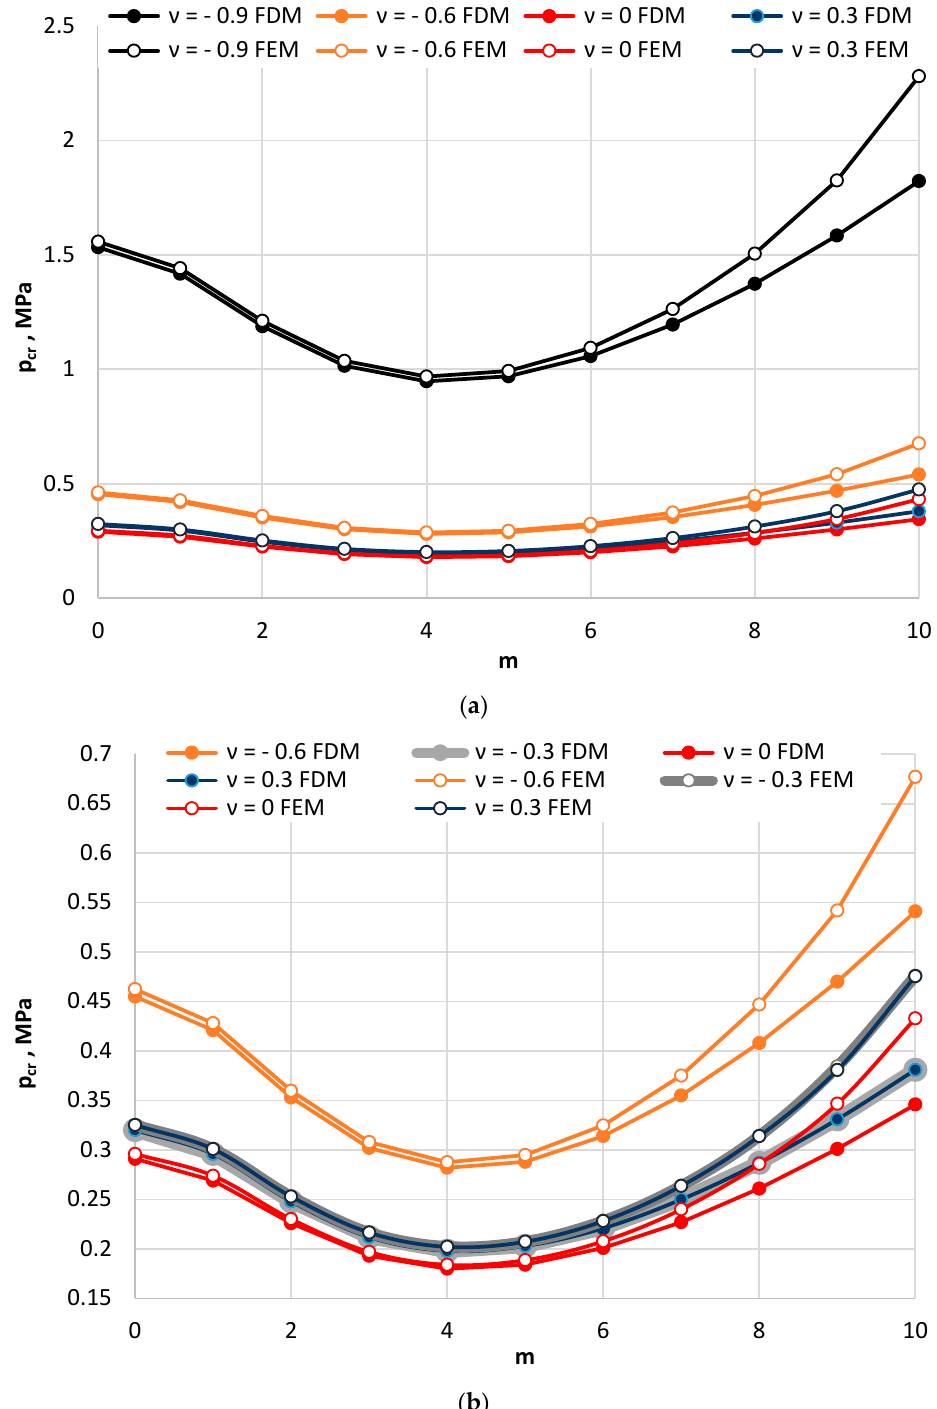
Figure 5. Critical static load p cr distribution versus mode m for the FDM and FEM homogeneous plate models radially compressed on the outer edge: for values of Poisson’s ratio ν = − 0.9, − 0.6 and ν = 0, 0.3 ( a ), for values of Poisson’s ratio − 0.6 ≤ ν ≤ 0.3 ( b ).